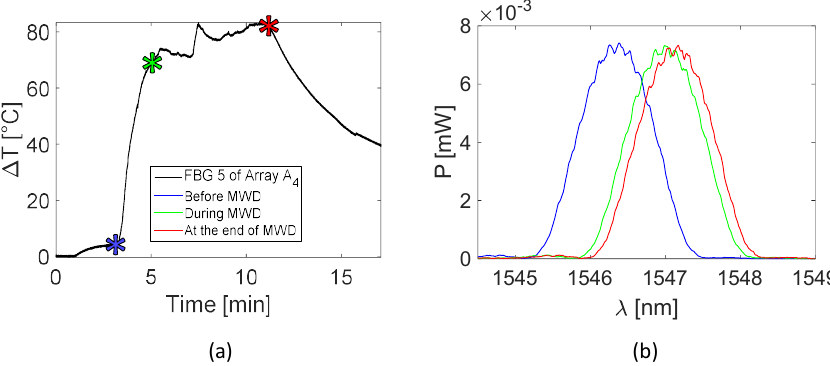
Figure 9. Focus on the fifth FBG of array A 4 , the sensor which recorded the maximum temperature value during the MWA treatment: ( a ) temperature variation versus time; ( b ) optical reflected spectra before, during and at the end of the MW discharge (MWD), in the three different instants of time marked in ( a ), plotted in green, blue and red respectively.